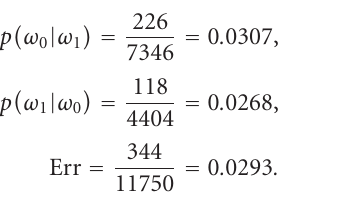
The error rate of DB2 is the